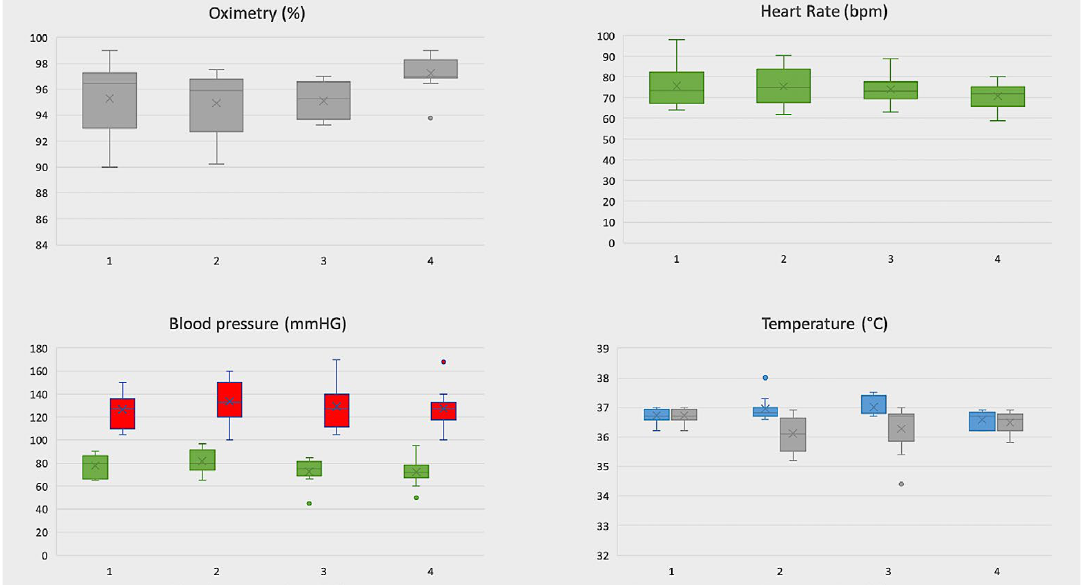
Figure 2. Graphical representation of measurement for each vital sign. The box is bounded by the first (bottom) and third (top) quartiles. The median is represented as a line in the box whereas the mean as a X. In red systolic pression, in green diastolic pression, in blue higher temperature, in gray lower temperature.